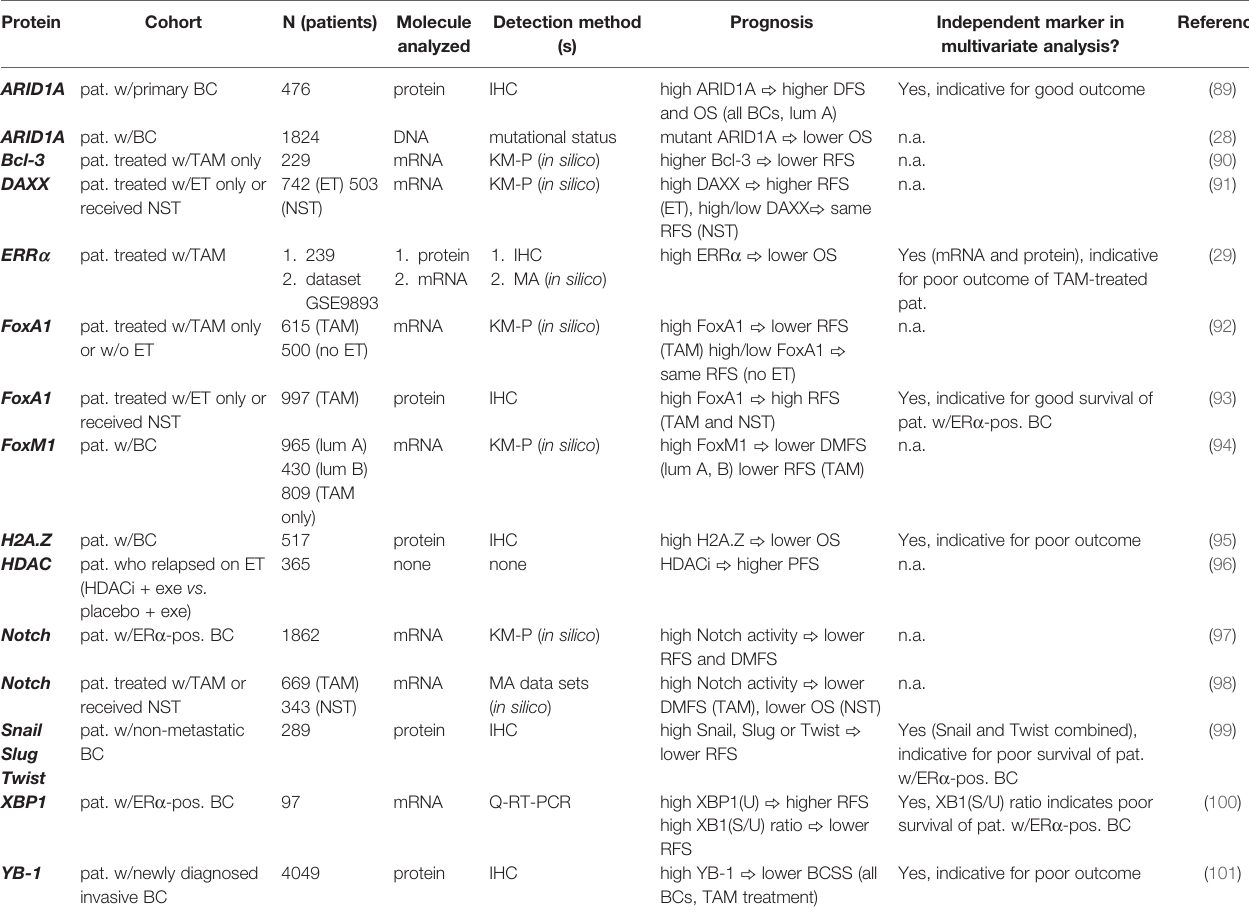
TABLE 1 | Nuclear proteins linked to endocrine resistance and their impacts on clinical outcome in breast cancer. Protein N (patients) Molecule